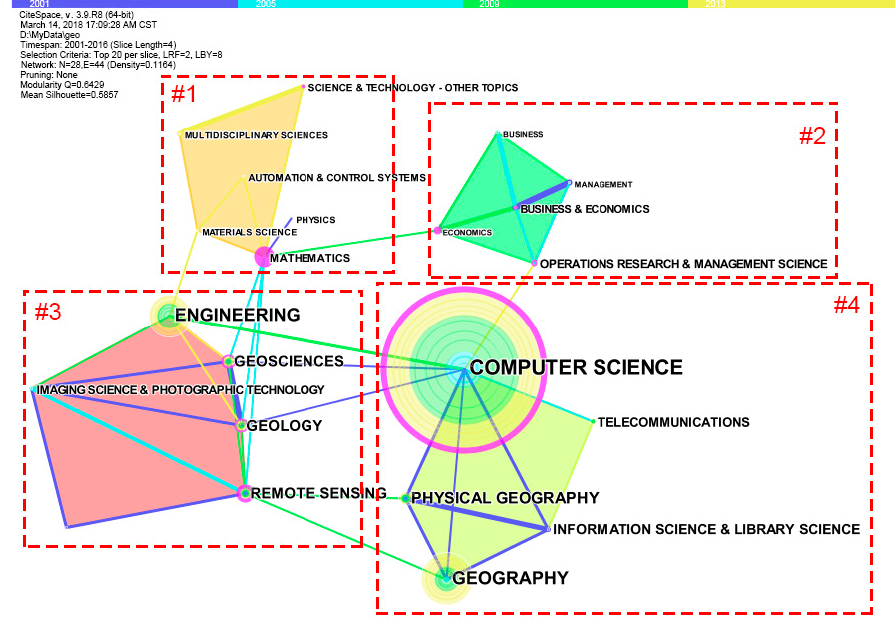
Figure 2. Cluster network of the co-occurrence of subject categories with 28 categories and 44 links.